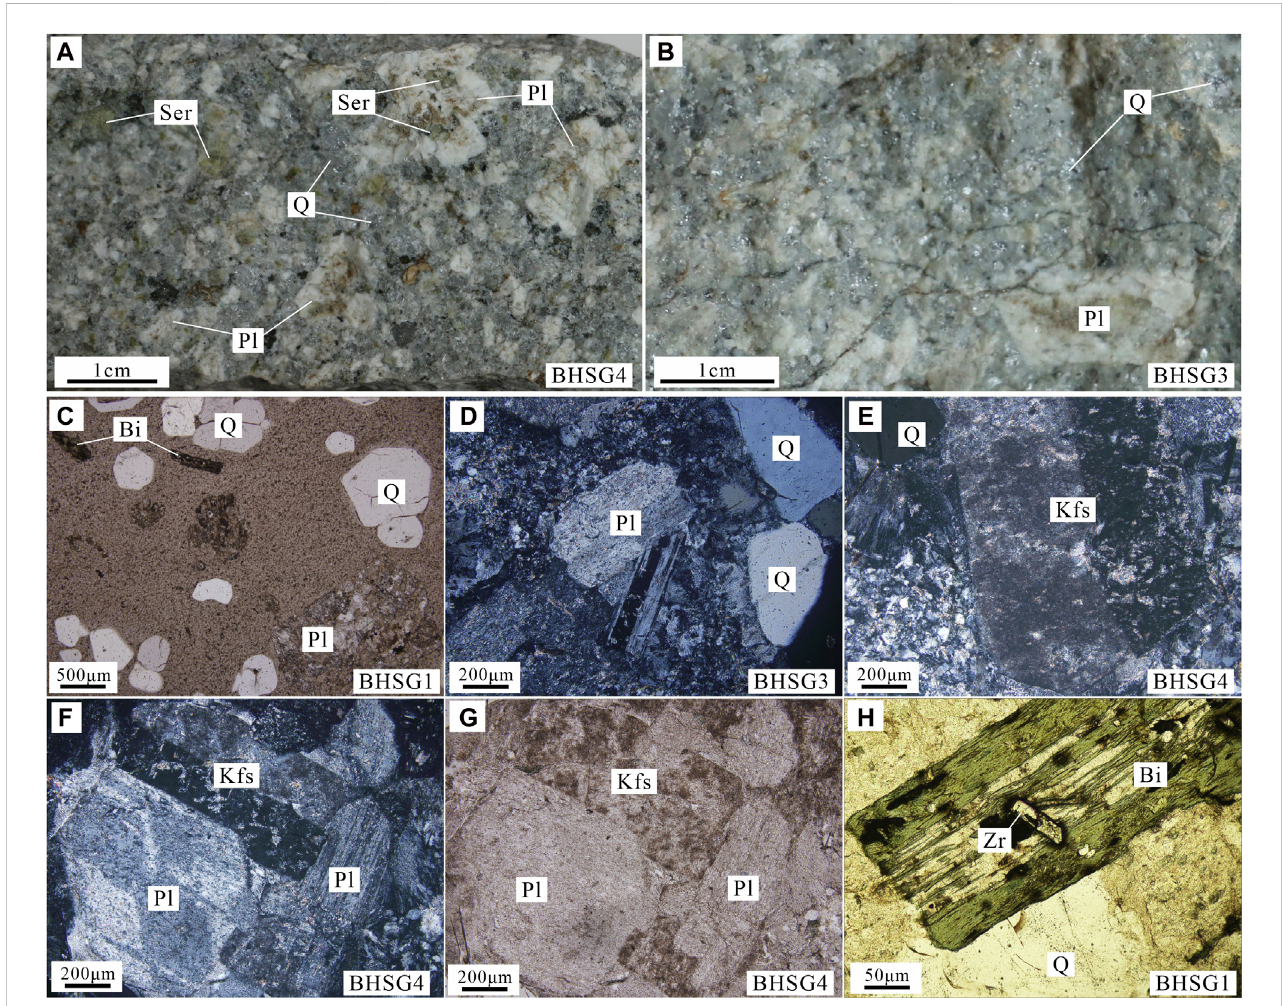
FIGURE 4 Hand specimens (A,B) and microscope photographs (C – H) of BHSG. Abbreviations: Bi, biotite; Kfs, K-feldspar; Pl, plagioclase;Q, quartz; Ser, sericite; Zr,